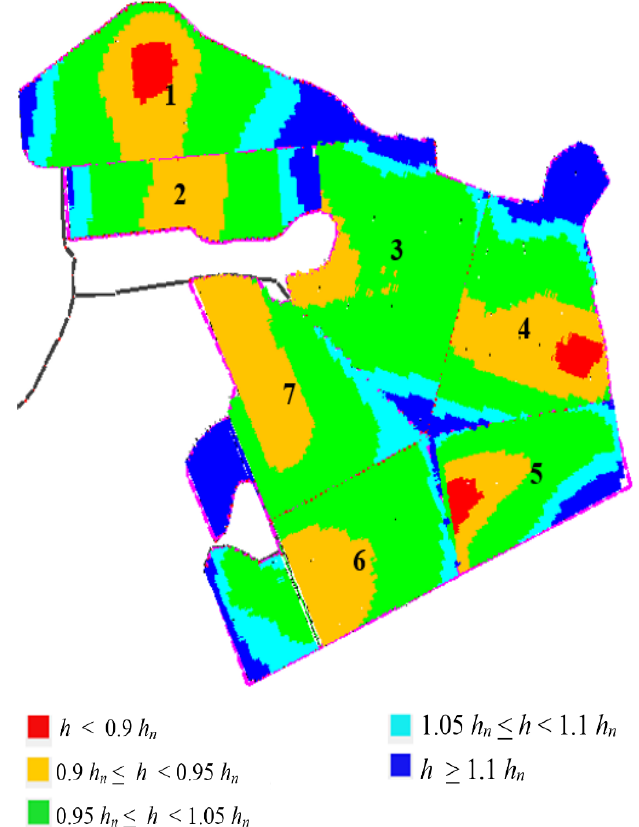
Figure 7. Emitters’ pressure head distribution map, pertaining to the design parameters of IRRILAB, by using common emitters (CEs) for the farm subdivided into seven sectors.